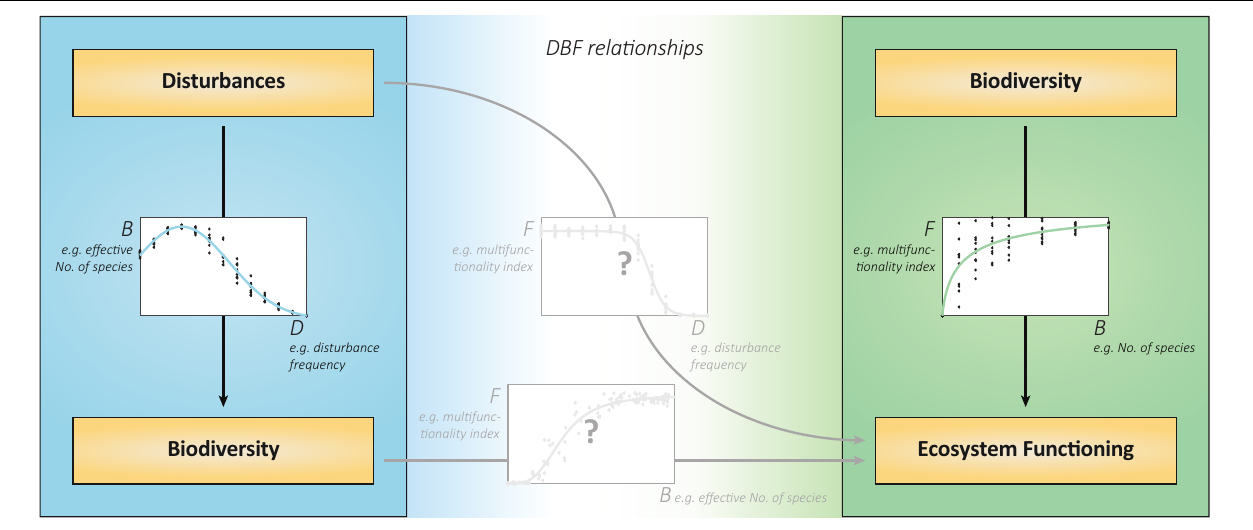
FIGURE 1 | DBF relationships integrate disturbances, biodiversity, and ecosystem functioning. The relationships between disturbances and biodiversity (left) and between biodiversity and ecosystem functions (right) have so far mostly been studied in isolation. The joint analysis will reveal the consequences of disturbances for ecosystem functioning (middle graph). In explaining these consequences, the relationship between realized biodiversity under disturbances and associated functioning (bottom graph) is decisive. This relationship does not show the effects of biodiversity under otherwise equal conditions, but the specific associations of realized biodiversity and ecosystem functioning (BEF) in various disturbance contexts. It is likely to deviate from the relationship between biodiversity of different, randomly assembled communities, and their functioning (right graph). This is because the disturbance regimes will create different, yet realistic, subsets of theoretically possible community compositions than the random artificial assembly. In addition, the associated functioning includes direct effects of disturbances that are not mediated by biodiversity changes. All graphs show virtual data that are consistent with each other. The chosen exemplary metrics of disturbances, biodiversity and ecosystem functioning can be replaced by alternatives. The biodiversity metric “effective number of species” comprises the components richness and evenness and is calculated from species abundances (Tuomisto, 2012).